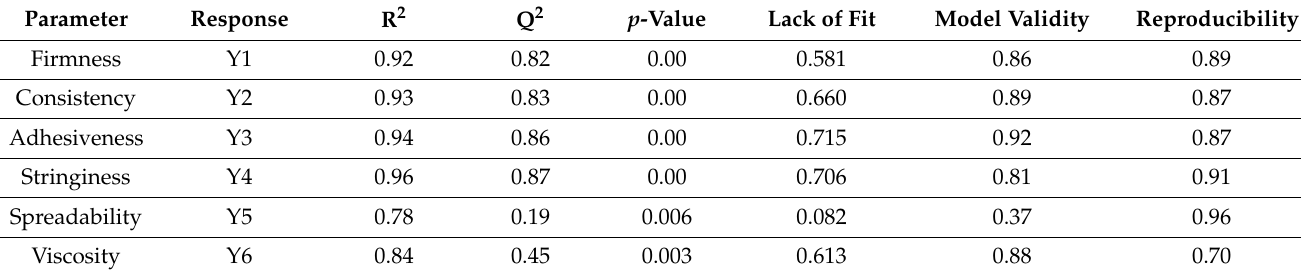
Table 5. Statistical parameters for ANOVA test and quality of